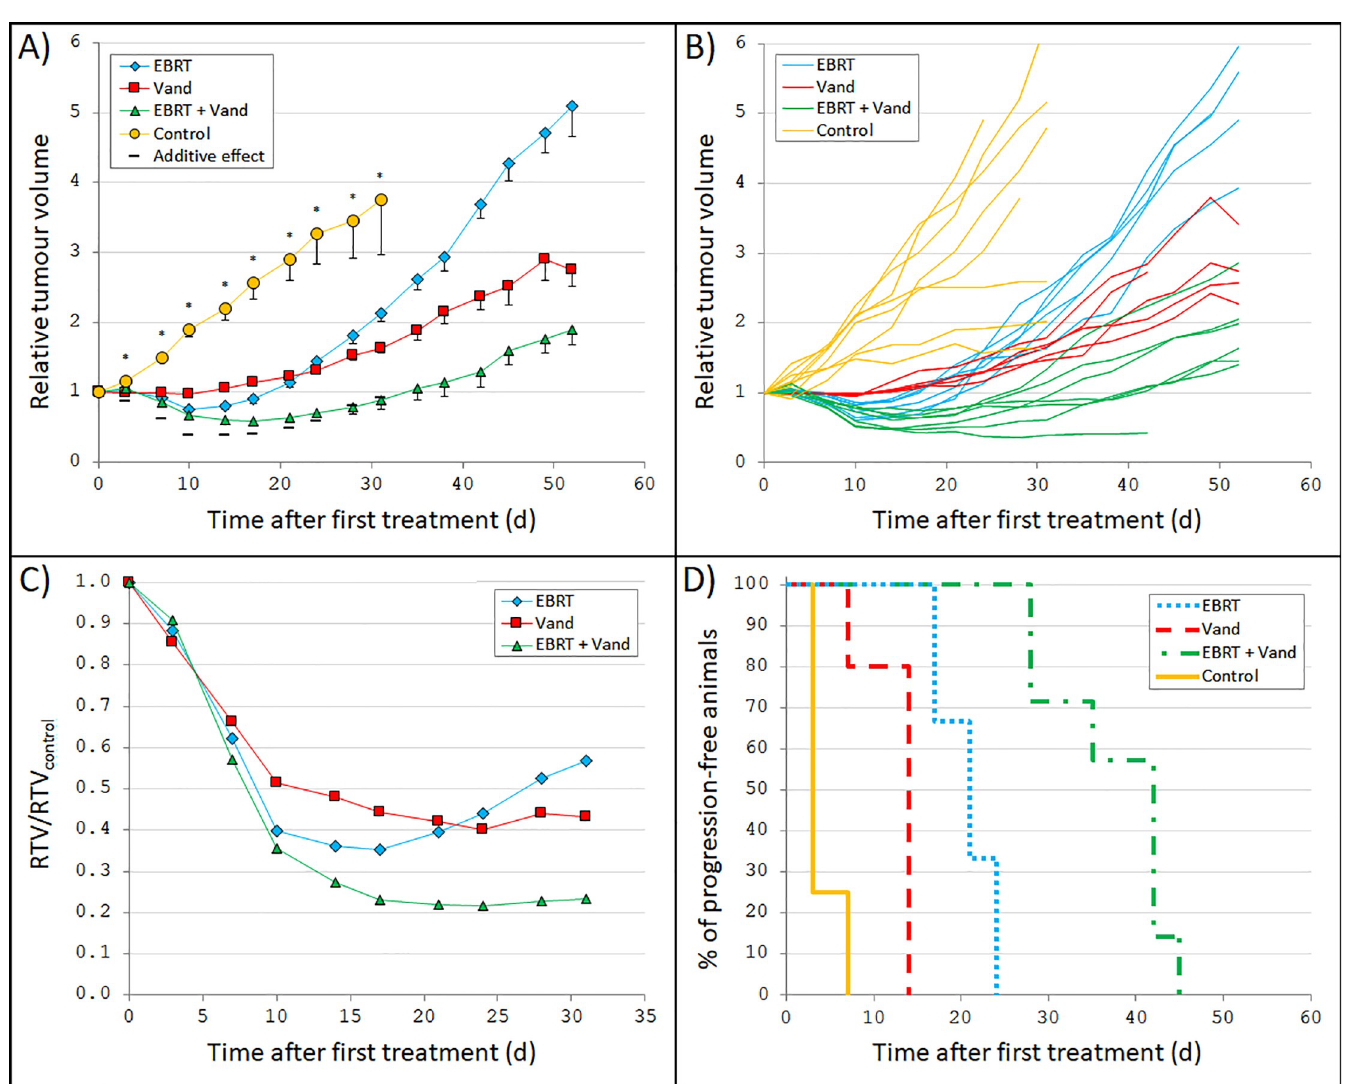
Fig 1. Tumour growth after radiation and/or vandetanib treatment. Nude mice carrying GOT2 tumours were treated with external beam radiotherapy (EBRT), vandetanib (Vand), a combination of both, or mock-treated as control. The absorbed dose from EBRT (3 Gy in one exposure on day 0) and the amount of vandetanib (100 mg/kg twice weekly) were chosen to give a moderate treatment effect to be able to detect any increased effect from combination therapy. (A) Mean relative tumour volume (RTV) vs . time after start of treatment. RTV was calculated as the tumour volume at a given time divided by the tumour volume at start of treatment. Included are also the corresponding calculated RTVs given a predicted additive effect (Eq. ((1)). Error bars represent SEM. The stars indicate that there was a statistically significant difference between the group means (ANOVA performed at day 3–31; p < 0.05). (B) Individual curves of RTV vs . time after start of treatment for each mouse. (C) Group-wise mean RTV compared with control (RTV/RTV control ) vs . time after start of treatment. Note the difference in x-axis scale. (D) Progression-free survival (percentage of animals without tumour progression) vs . time after start of